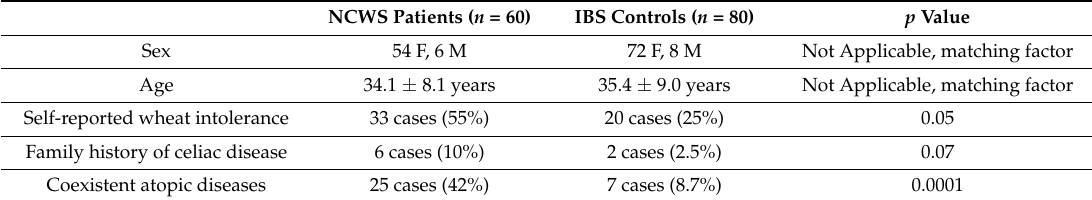
Table 1. Clinical characteristics of the NCWS patients compared to the control group composed of patients suffering from IBS who did not improve on elimination